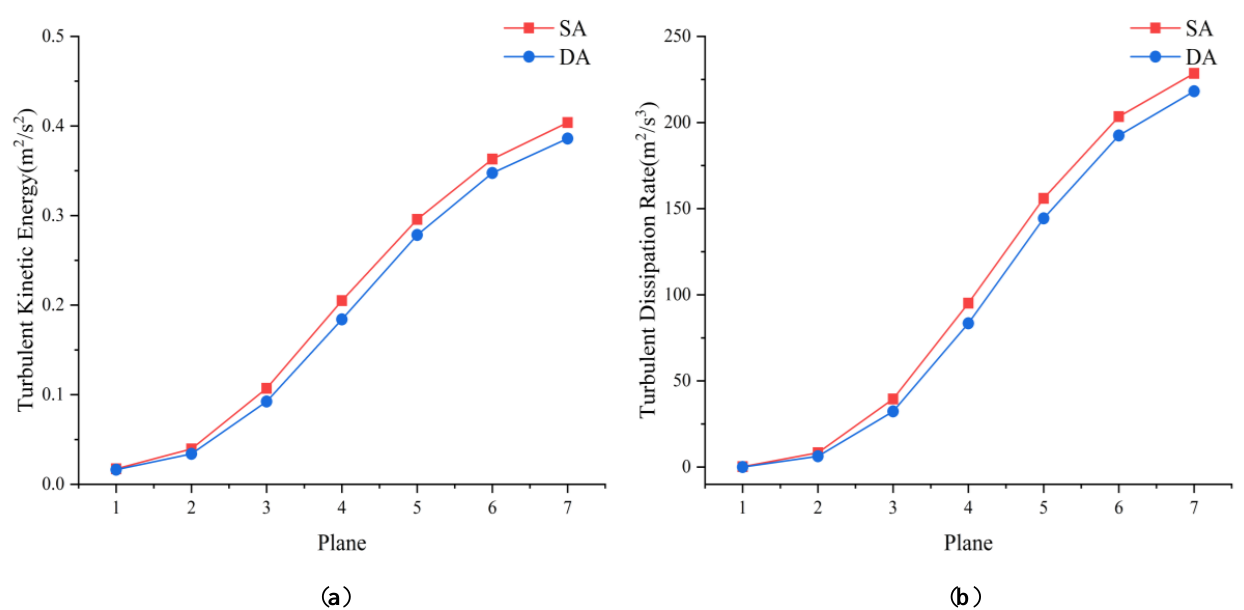
Figure 11. Turbulent kinetic energy performance on 7 planes: ( a ) Turbulent kinetic energy of SA and DA on 7 planes; ( b ) Turbulent energy dissipation of SA and DA on 7 planes.